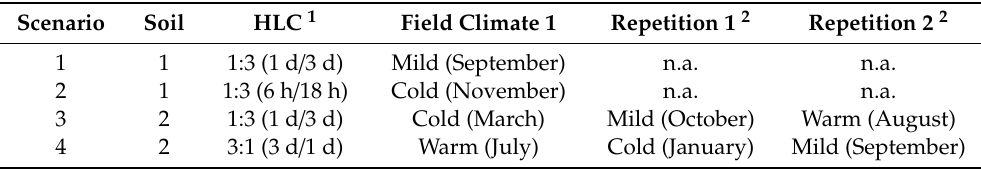
Table 1. Setup specifics for different infiltration scenarios. Field experiments of scenario 3 and 4 were repeated under various climates.